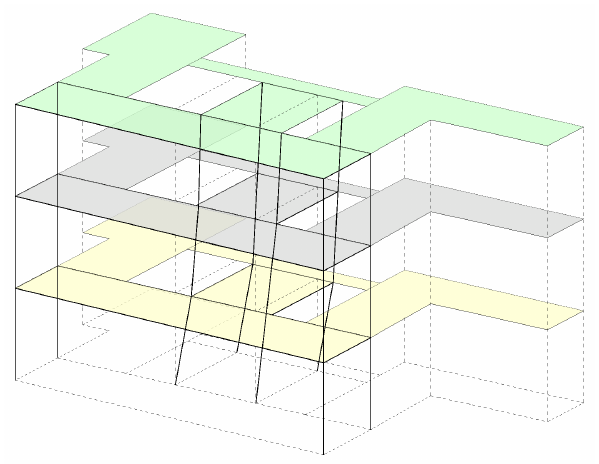
Figure 6. Translational mode in direction X.